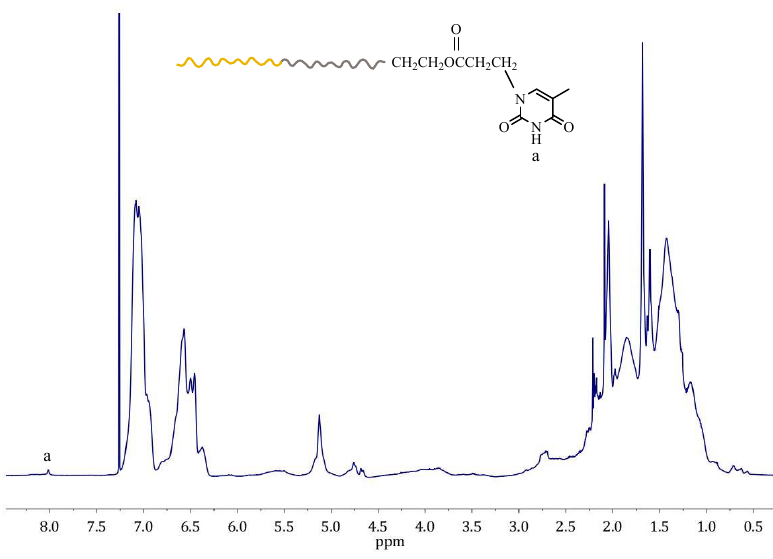
Figure 3. 1 H ‐ NMR spectrum of sample PS ‐ Dap.